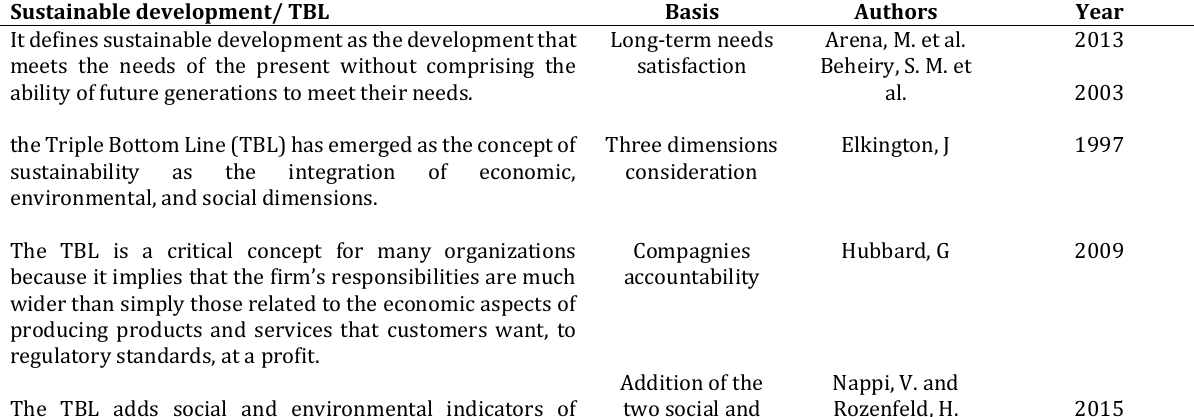
Table 4: Sustainable development Sustainable development/